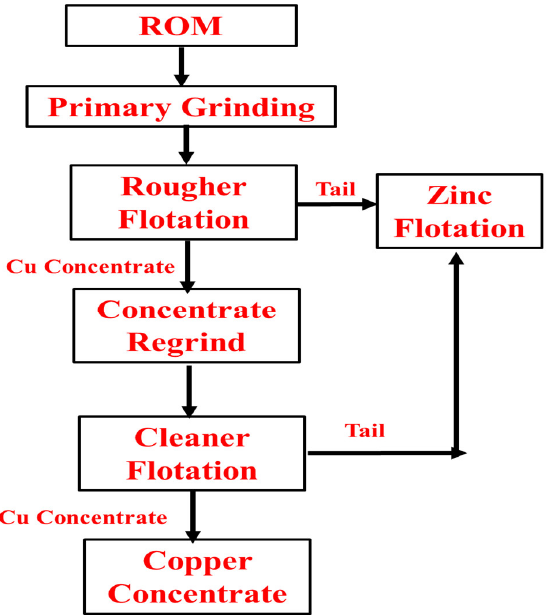
Figure 26. Flow sheet of the Cerro de Maimón copper plant (Dominican Republic) [157]. Table 12. Summary of the copper plant flow sheets. Sl.